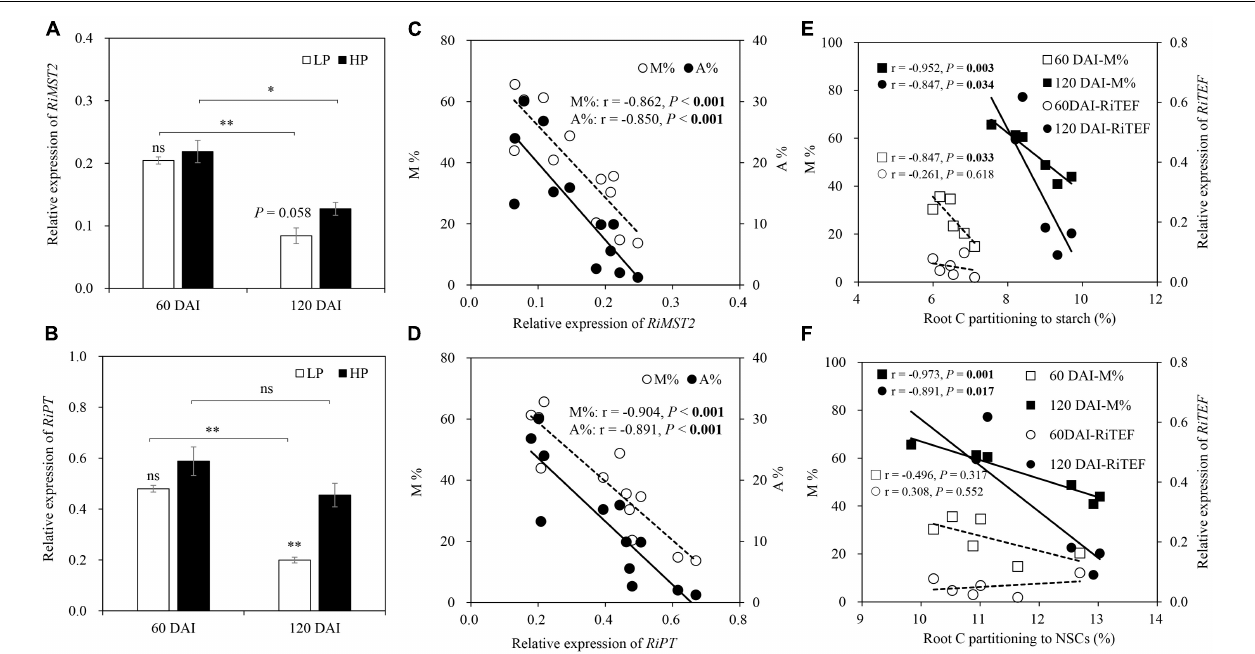
FIGURE 7 | Relative expression of (A) RiMST2 and (B) RiPT as affected by soil P levels 60 and 120 days after inoculation (DAI). LP and HP represent 30 and 170 mg kg − 1 P application, respectively. Data are presented as mean ± standard error (SE, n = 3). Treatment effects were tested by Student’s t -test at the P < 0.05 level. ∗ P < 0.05; ∗∗ P < 0.01; ns, not significant. M and A% in relation to the relative expression of (C) RiMST2 and (D) RiPT for +M plants across two harvests. M% and RiTEF expression in relation to root C partitioning to (E) starch and (F) NSCs for the –M and +M plants at two harvests separately. Pearson correlation analyses were conducted to check the